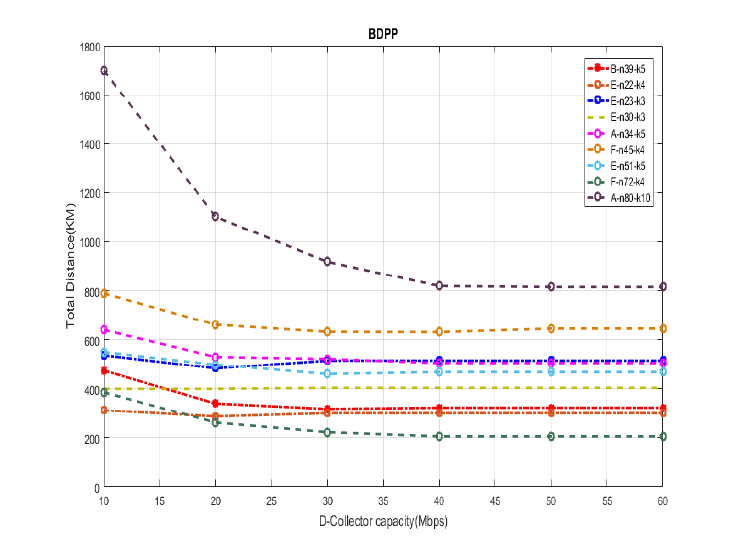
Figure 12. D-collector capacity vs. total distance (BDPP).